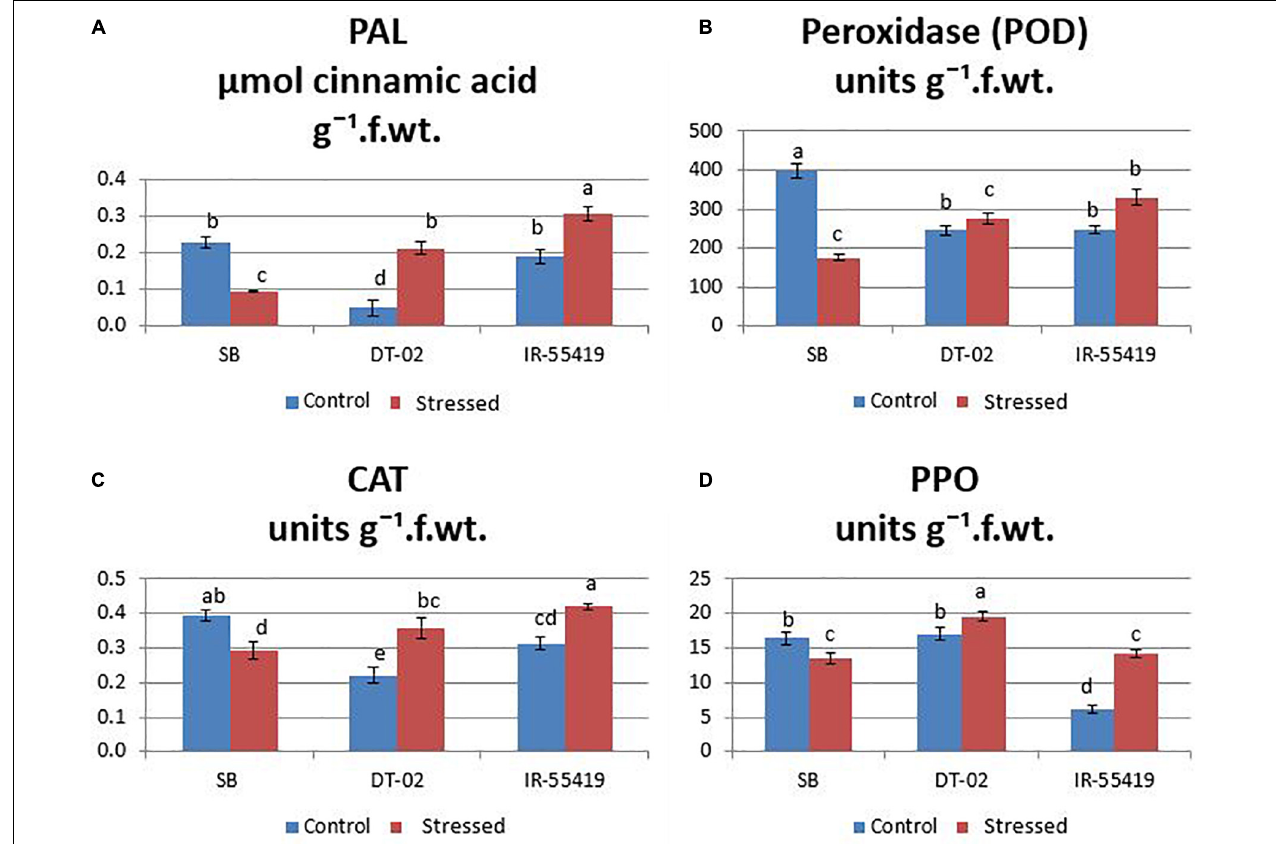
FIGURE 6 | Induction of defense-related enzymes. (A) Phenylalanine ammonia lyase (PAL). (B) Peroxidase (POD). (C) Catalase (CAT). (D) Polyphenol oxidase (PPO) in rice plants of genotypes SB, IR-55419 and DT-02 under control-fully irrigated and stressed-water with holding for 15 days at 30 days after transplantation (DAT). Bars indicate the SD of three biological replicates and each replicate has three plants (ten leaves per plant). Data represented as means and means with the same letter differ non-significantly at p = 0.05 according to